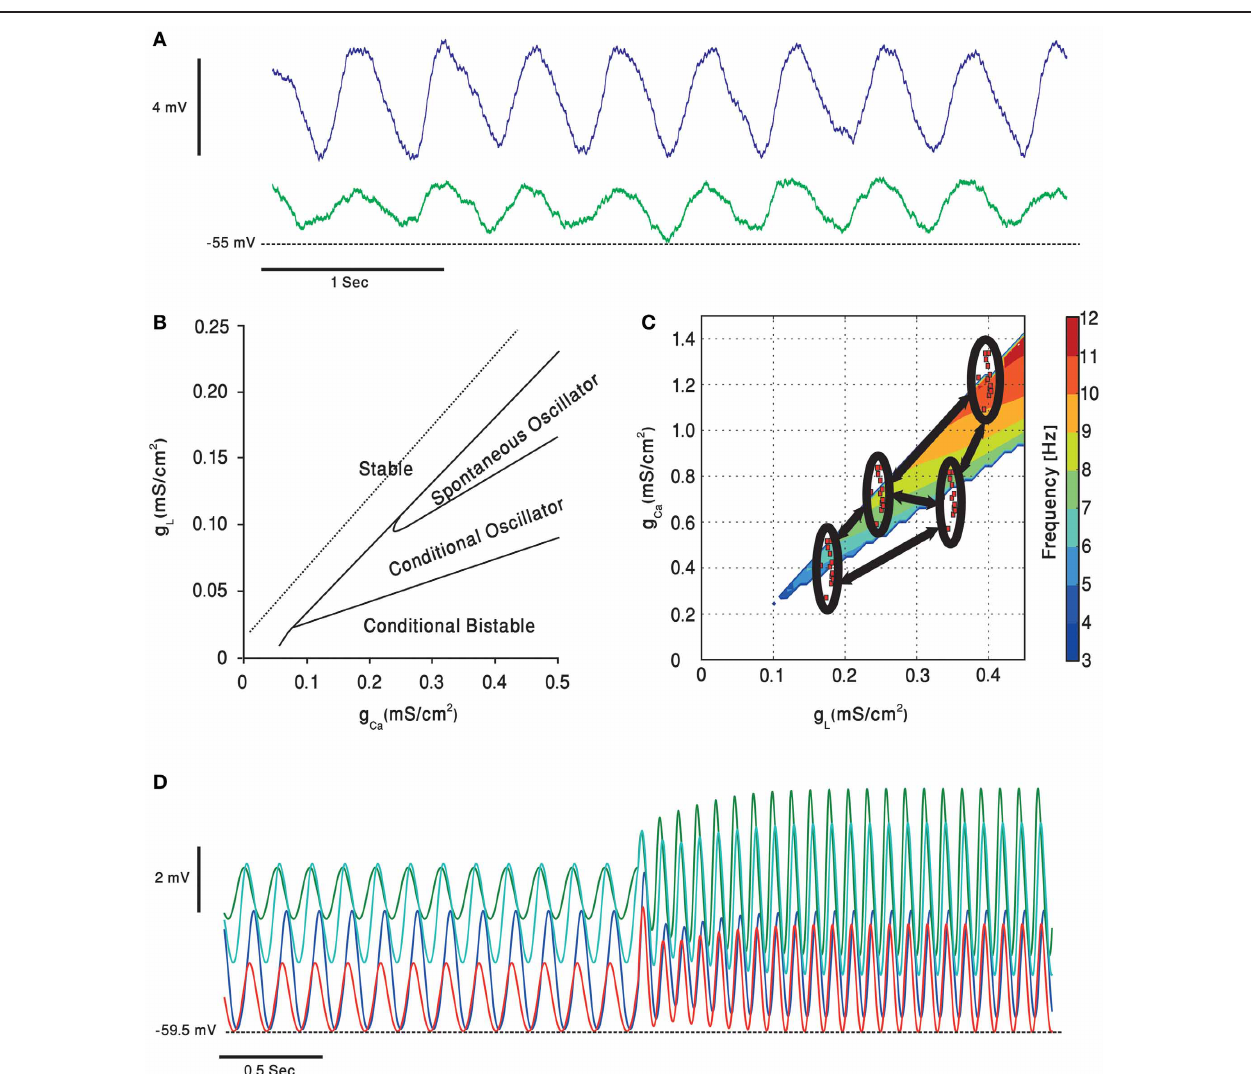
FIGURE 5 | Subthreshold oscillations of the olivary neurons membrane potential. (A) Whole cell recording, in an in vitro preparation, of two coupled olivary neurons oscillating together. (B) A simulated olivary neuron behavior on dependence on the calcium and potassium leak conductance [adapted from Manor et al. (1997)]. Oscillations spontaneously occur in a restricted part of the plane. (C) Dependence of the olivary neurons subthreshold oscillations frequency, in the clustered olive model, on potassium leak and calcium conductance [adapted from Torben-Nielsen et al. (2012)]. Each of the clusters (red dots inside black